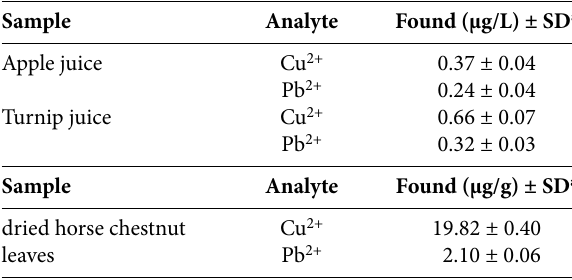
Fig. 9. DPSAV curves of blank solution (a), real sample without addi- tion of Pb(II) and Cu(II) (b) and after additition of different concen- trations of Pb(II) and Cu(II) (c–f) at CNT-Calix/CPE in 0.20 M PBS pH 5.0 buffer solution. Deposition potential: ‒1.0 V; deposition time: table 5. Simultaneous determination of metal ions in several real samples by the proposed method (n = 5).